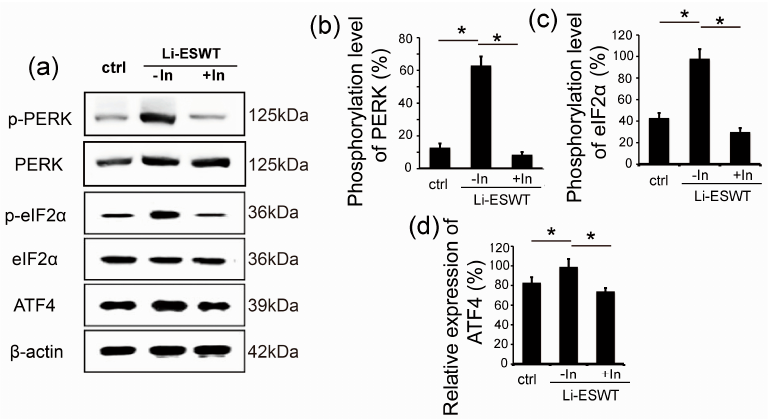
Figure 3. GSK2656157 effectively inhibited the phosphorylation of PERK and eIF2 α and the expression of ATF4 in RT4-D6P2T. ( a ) Expression of p-PERK, PERK, p-eIF2 α , eIF2 α , and ATF4 with usage of Li-ESWT and PERK inhibitor (In) GSK2656157 ( n = 3 in triplicates); ( b ) The phosphorylation level of PERK increased significantly with Li-ESWT, and could be blocked by GSK2656157 (* p < 0.05). Intensity protein expression; ( c ) Phosphorylation level of eIF2 α increased significantly with Li-ESWT, and